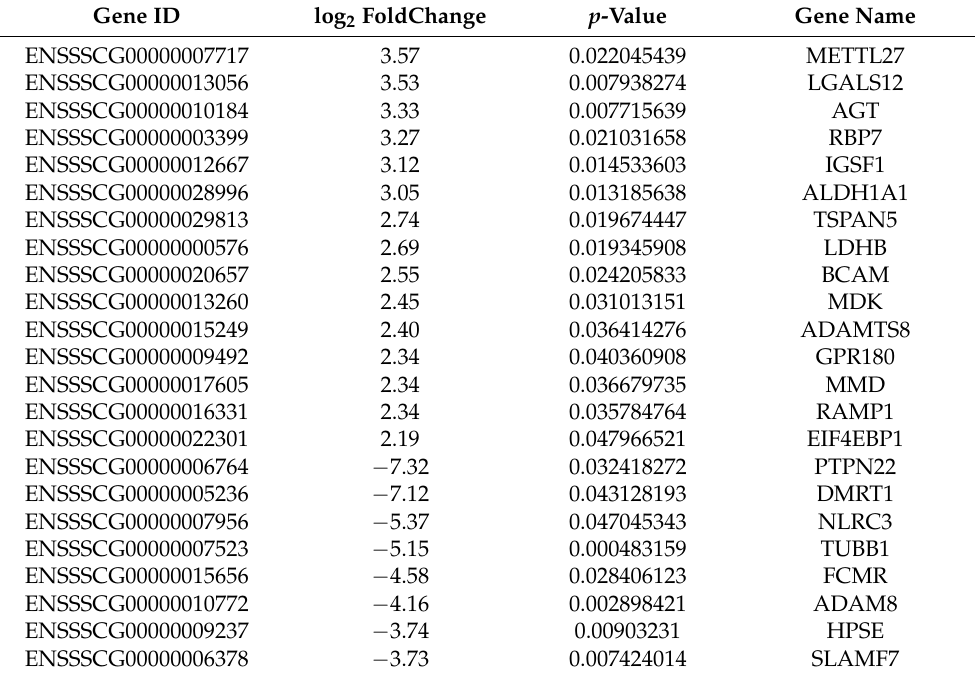
Table 5. Differentially expressed genes (DEGs) while comparing scrambled peptide treated FA with LR-12 + TAK-242 treated AVF FA (+value = higher expression in scrambled peptide treated AVF FA; − value = higher expression in LR-12 + TAK-242 treated AVF femoral